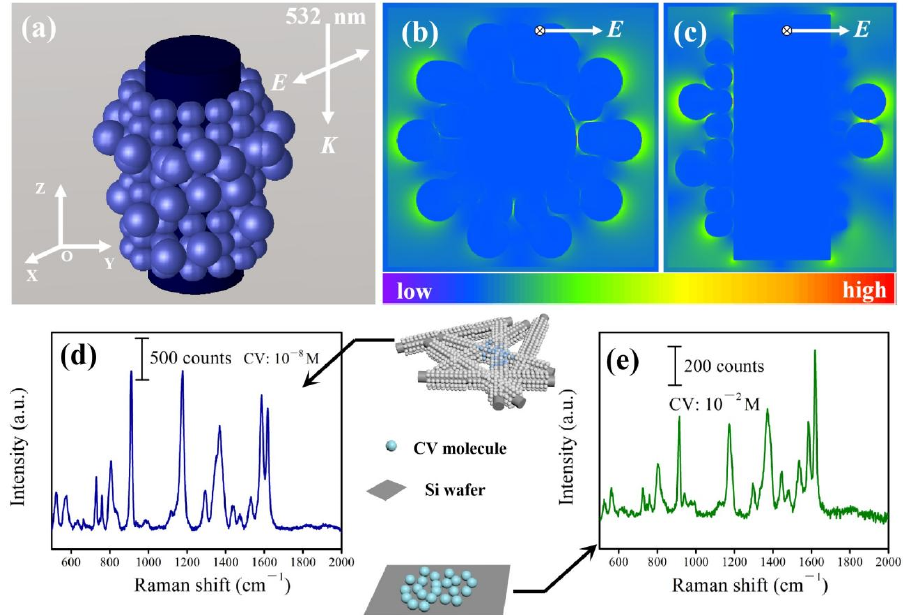
Figure 10. ( a ) 3D-FDTD model of Ag 25 -C-fiber substrate; ( b , c ) spatial distributions of electromagnetic field intensity of Ag 25 -C-fiber model in x-y plane and x-z plane; ( d ) Raman spectrum of 10 − 8 M CV solution on Ag 25 -C-fiber substrate; ( e ) Raman spectrum of 10 − 2 M CV solution on Si wafer.